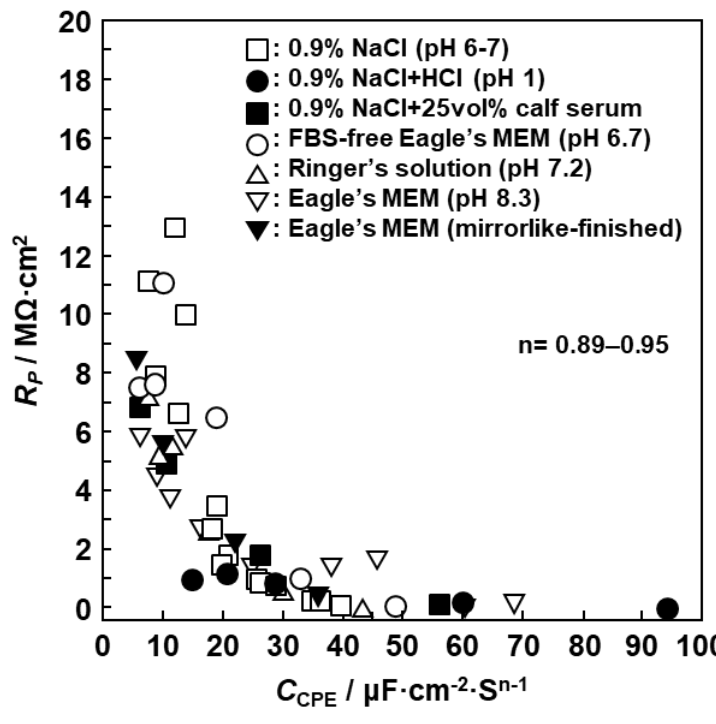
Figure 13. Effects of biological solutions and pH on R P and C CPE diagram of oxide films formed on 1000-grit-polished Ti–15Zr–4Nb–4Ta alloy.